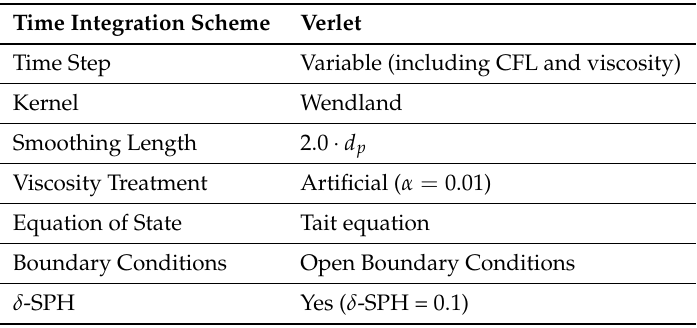
Table 2. SPH formulation and